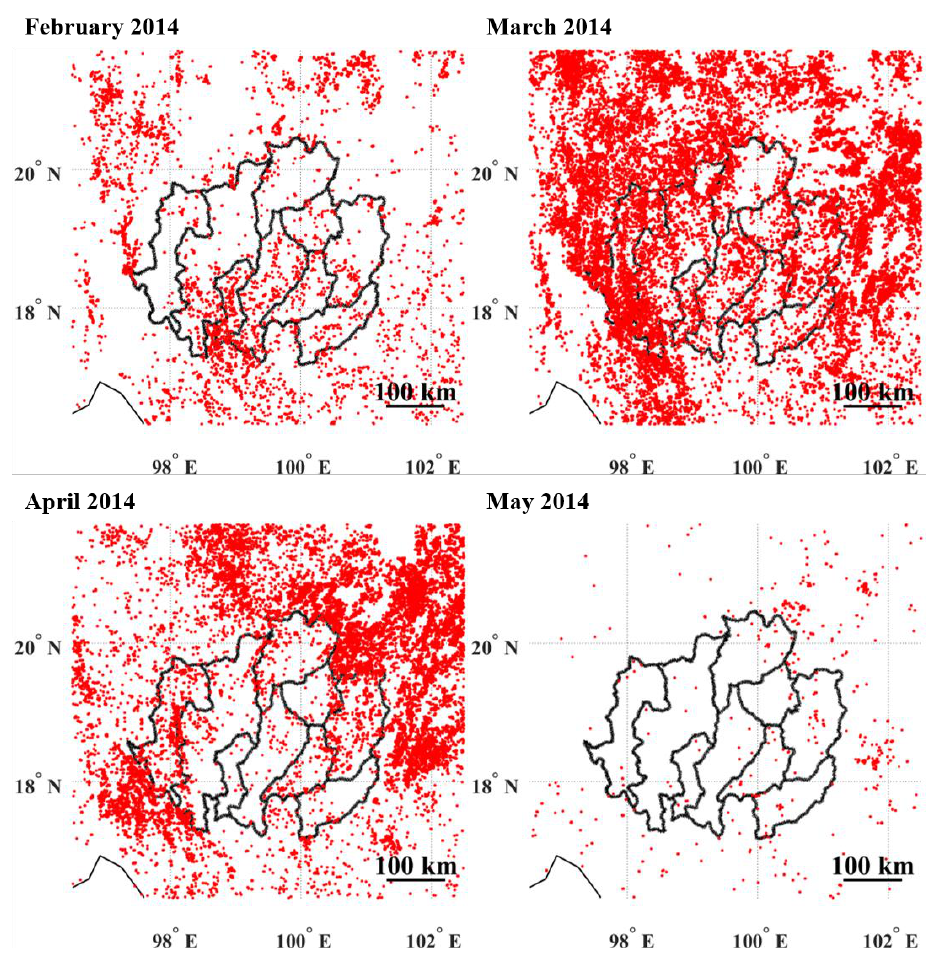
Figure 2. All hotspots occurring in February–May of 2014 in the study area and neighboring regions.